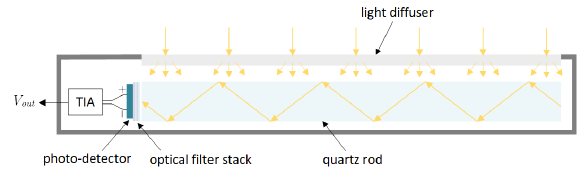
Fig. 12. Architecture of a line PAR